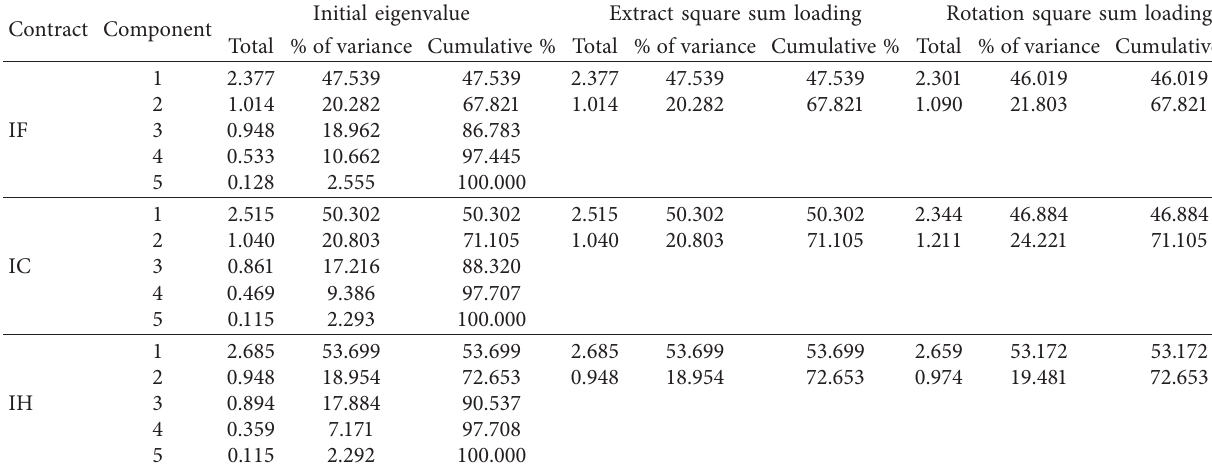
Table 10: The explanatory total variance.